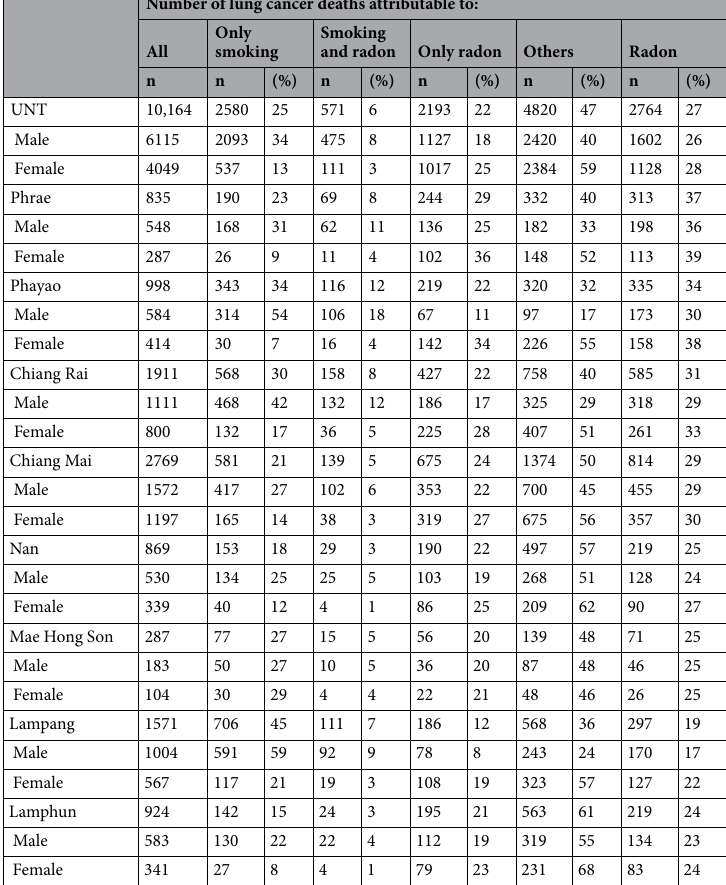
Table 5. The estimates of lung cancer deaths attributable to indoor radon exposure from 2015—2019 in the eight provinces of upper northern Thailand (UNT).